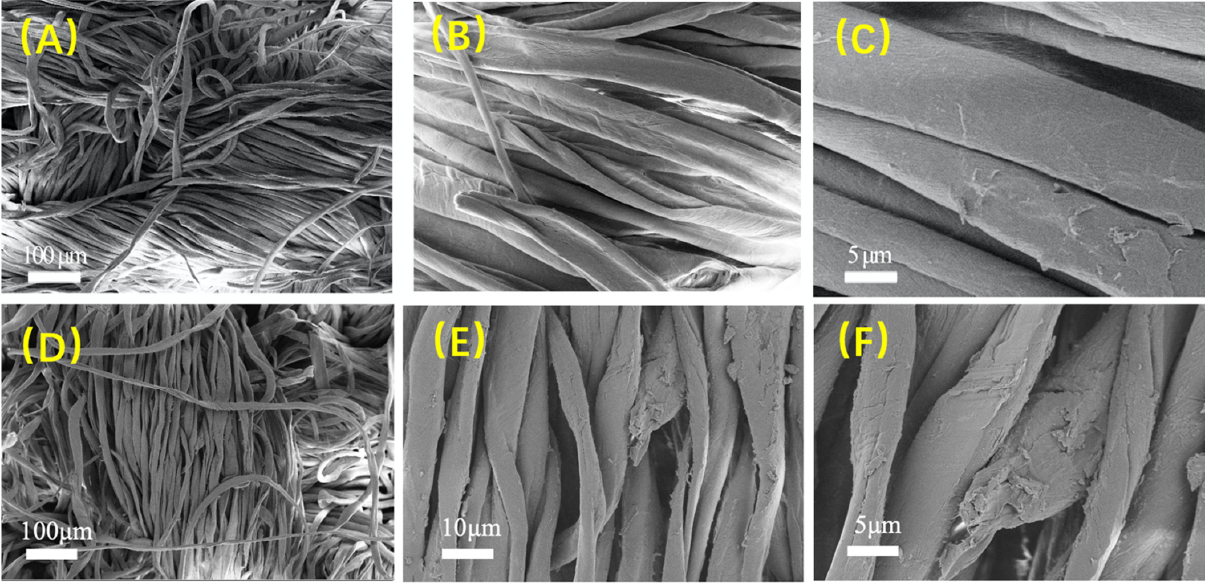
Figure 5. SEM images of cotton fabric with different magnifications: ( A – C ) Before finishing cotton fabric; ( D – F ) after p(DMAPS ‐ co ‐ G06B) ‐ b ‐ KH590 (RUN5) finishing treatment.